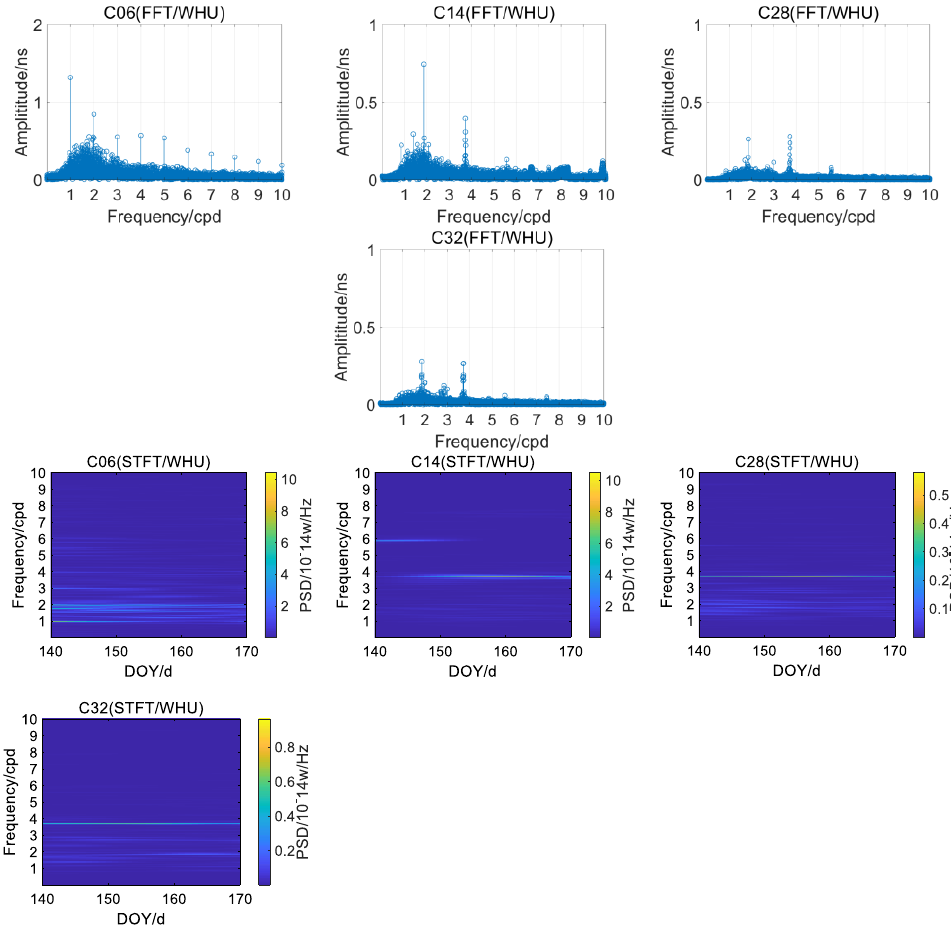
Figure 11. Amplitude spectrums and spectrograms of WHU clock offsets.